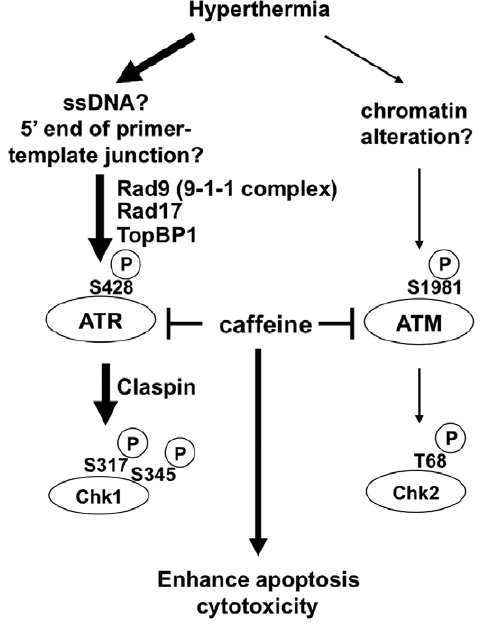
Figure 7. Model of cellular response to heat stress. See text for